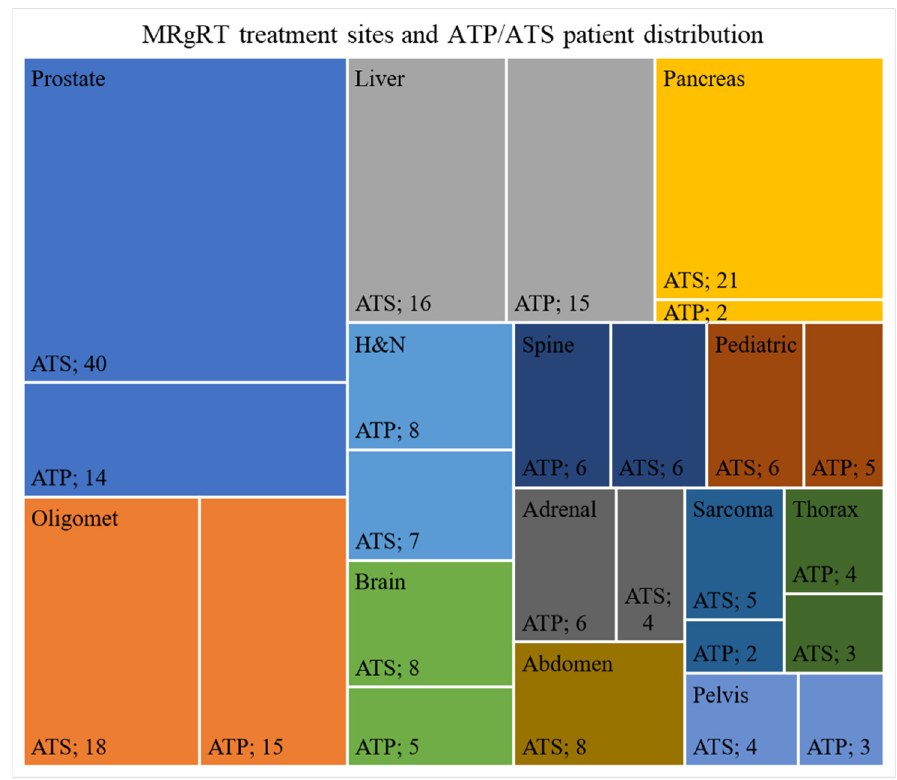
Figure 1. Distribution of treatment sites and patients treated with at least one ATS fraction or all ATP treatments.